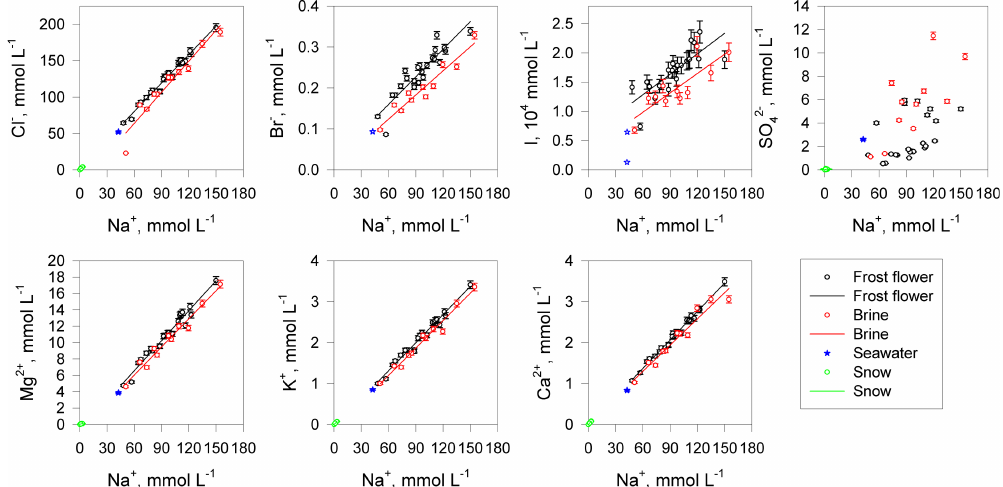
Figure 4. Relationship among each component with Na + concentrations of frost flowers, brine, and seawater taken in this study. Black and red lines respectively present regression lines of frost flowers and brine. Open black and red circles respectively present concentrations in frost flowers and brine. Filled blue stars represent the concentrations of seawater taken around Siorapaluk. Open blue stars represent the concentrations of seawater in the literature presented in Table 1. Error bars indicate standard deviation (1 σ) of analytical